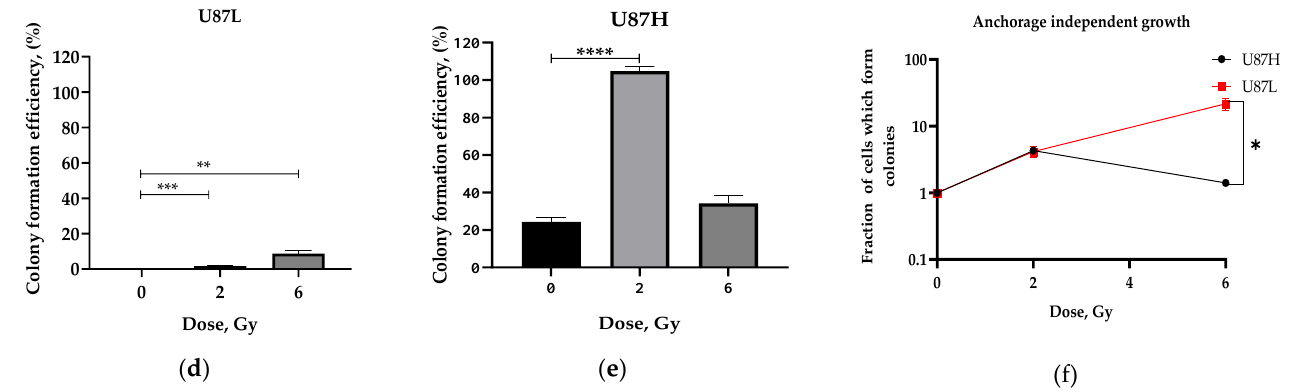
Figure 1. Plating efficiency of U87L ( a ) and U87H ( b ) cells after exposure to 2 and 6 Gy IR. Colony formation efficiency in soft agar of U87L ( d ) and U87H ( e ) cells after exposure to the same doses of IR. Reproductive survival of GBM cell lines was analyzed using survival fraction of cells grown under both anchorage-dependent ( c ) and anchorage-independent conditions ( f ). * p < 0.05; ** p < 0.01; *** p < 0.001; ***** p < 0.00001.